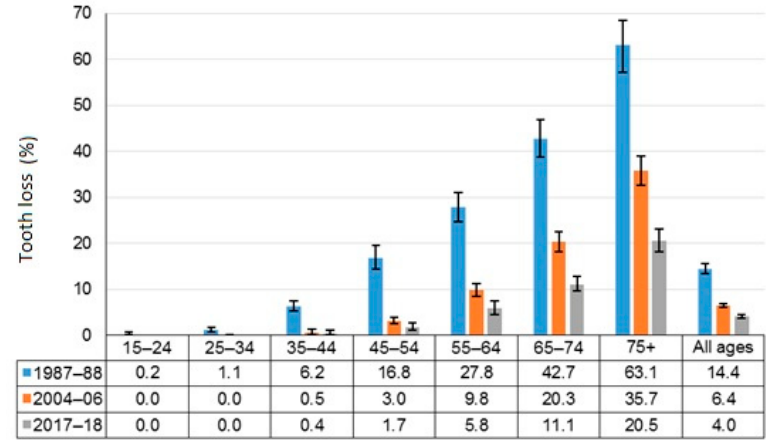
Figure 1. Trends in dental decay experience among dentate Australians aged 15 years and over, 1987–88, 2004–06 and 2017–18.